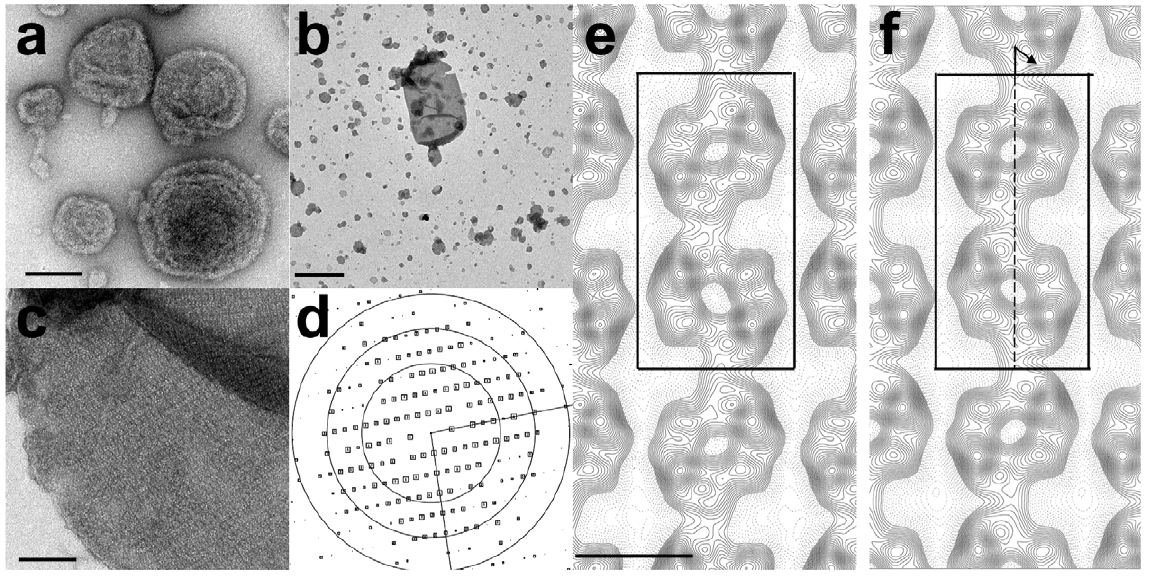
Figure 6. 2-D crystallization of BmrC/BmrD. BmrC/BmrD was reconstituted with PC/PA/cholesterol lipid mixture at 0.6 (w/w) as described in the Materials and Methods section in the absence ( a ) or in the presence ( b , c ) of ATP/MgCl 2 /vanadate. ( b , c ) Electron micrographs of negatively stained 2- D crystals. ( d ) Representation of amplitudes of Fourier components calculated for one image of a negatively stained crystal. Numbers and box sizes correspond to the spot IQ value, with spots of the highest signal-to-noise ratio having an IQ of 1 and the lowest of 5 [84]. The three black circles are at radii corresponding to 1/35, 1/24, 1/18 A˚ 2 1 . ( e , f ) Projection maps of BmrC/BmrD at 21 A˚ resolution calculated from merged amplitudes and phases from five independent crystals with p1 symmetry and p12 1 -b symmetry, respectively. Solid lines indicate density above the mean. Negative contours are indicated by dotted lines. The lattice parameters are a=122 A˚, b=236 A˚ and gamma=90 u . The unit cell, dark box, contains two supramolecular entities (one being outlined by a dotted, light gray box in e ), related by a screw axis along b (dotted arrow in f ). Scale bars are equal to 100 nm ( a and c ), 1 m m ( b ).